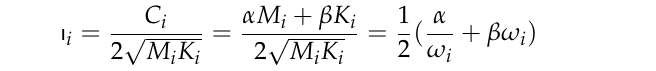
13 of 21 Figure 13. FEM model and modal analysis results for the OWT. The first-order mode of the OWT swings in the directions of the X -axis and Y -axis, and the natural frequency is approximately 0.265 Hz. The calculated first frequency was close to the actual frequency (0.26 Hz), and the second frequency was approximately 1.02 Hz. The dynamic characteristics of a structure are determined by mass, stiffness and damping. However, it is difficult to determine the real damping characteristics of a com-